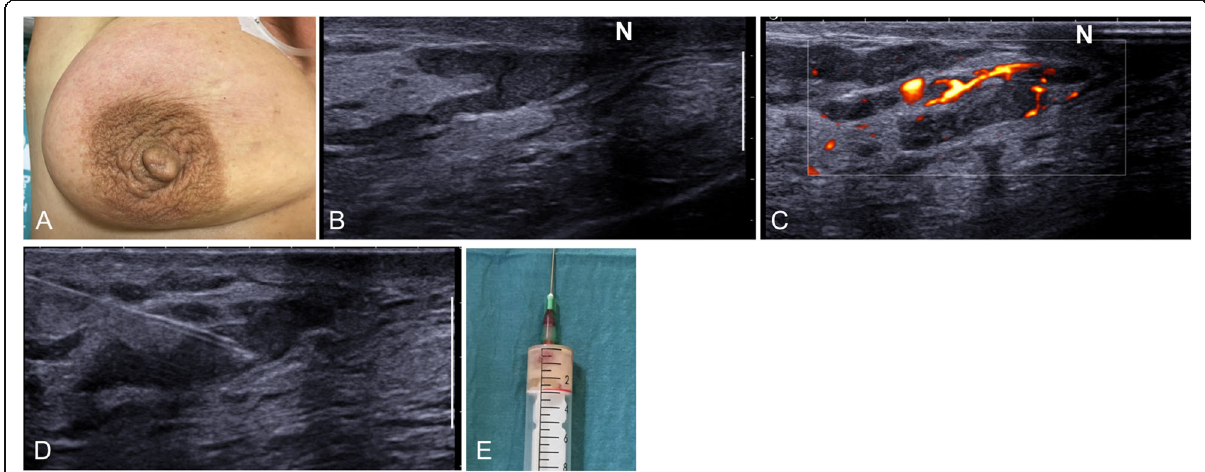
Fig. 21 Periductal mastitis. Photograph of a 59-year-old smoker with a painful erythematous area in the upper outer quadrant of her right breast ( a ). Ultrasound shows skin thickening and retroareolar ductal ectasia with echogenic contents ( b ) and increased periductal Doppler signal ( c ). Fine-needle aspiration obtained purulent material (pus) ( d , e )